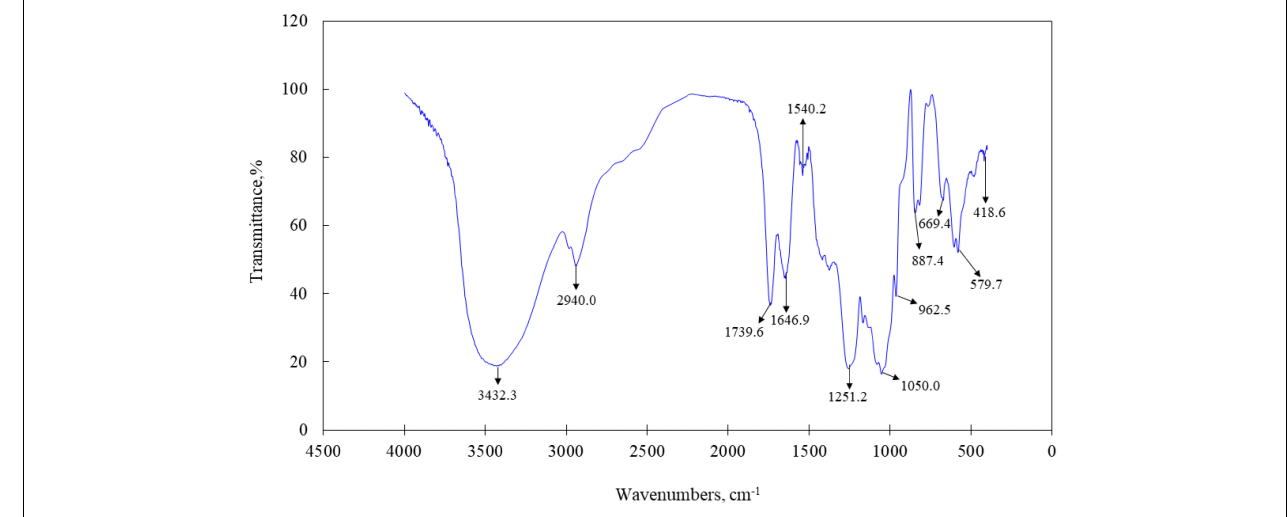
FIGURE 3 | Fourier transforms infrared (FT-IR) spectra of LJPS.